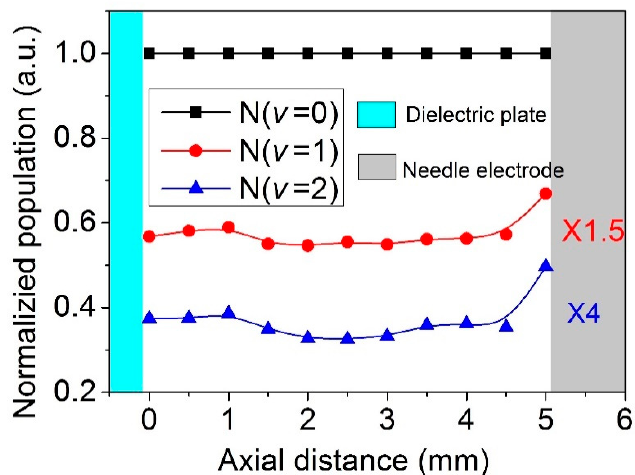
Figure 8. Spatial distribution of the relative vibrational populations of N 2 (C 3 Π u , v = 0), N 2 (C 3 Π u , v = 1), and N 2 (C 3 Π u , v = 2).